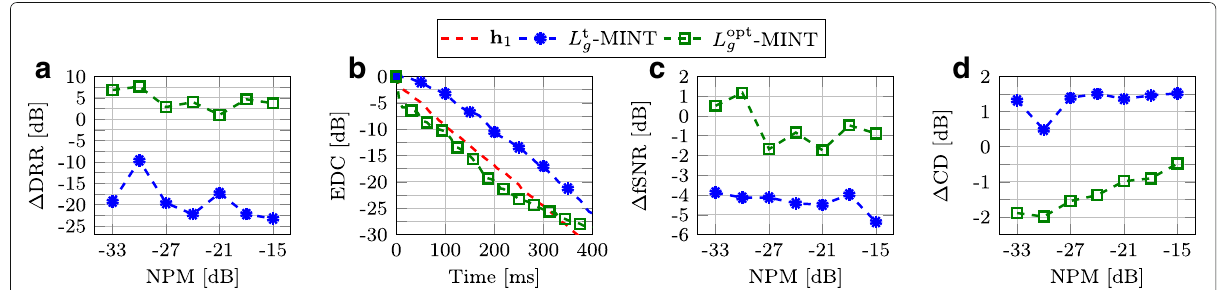
Fig. 5 Performance of MINT using the conventional filter length L t g and the optimal intrusively determined reshaping filter length L opt g for acoustic system S 1 in terms of a (cid:3) DRR, b EDC for an NPM of − 33 dB, c (cid:3) fSNR, and d (cid:3) CD